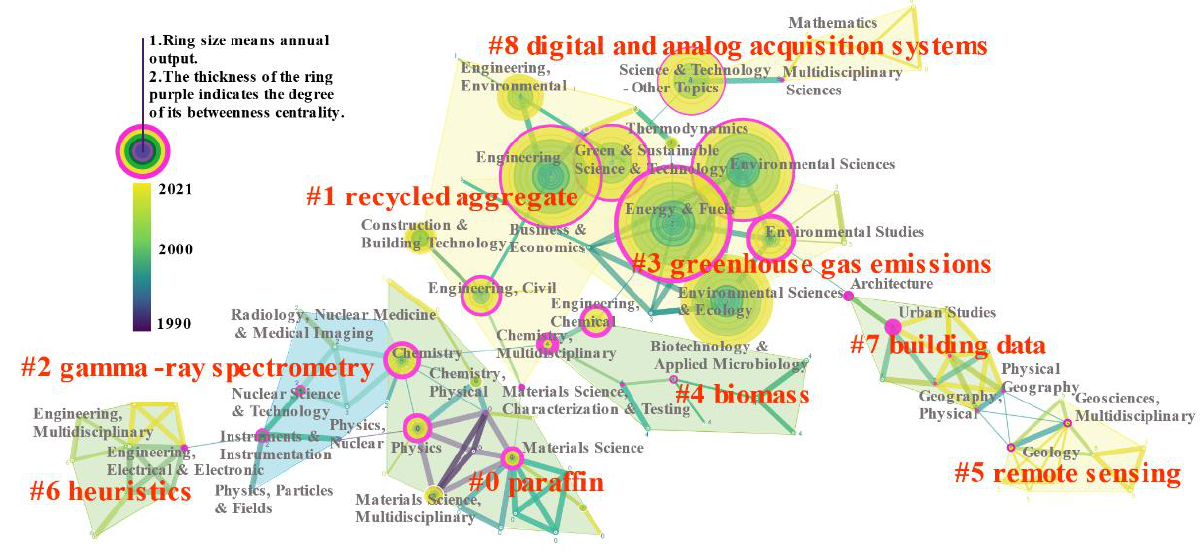
Figure 6. Cluster map of the co-occurrence of subject categories.